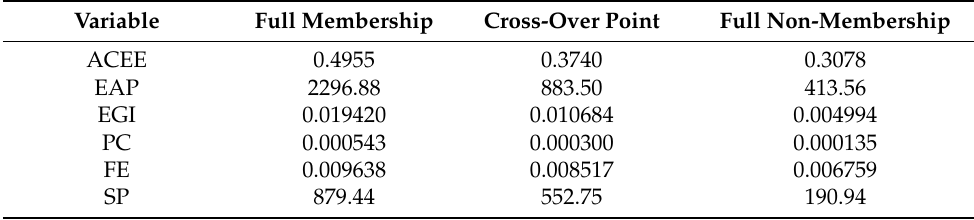
Table 5. Variable calibration